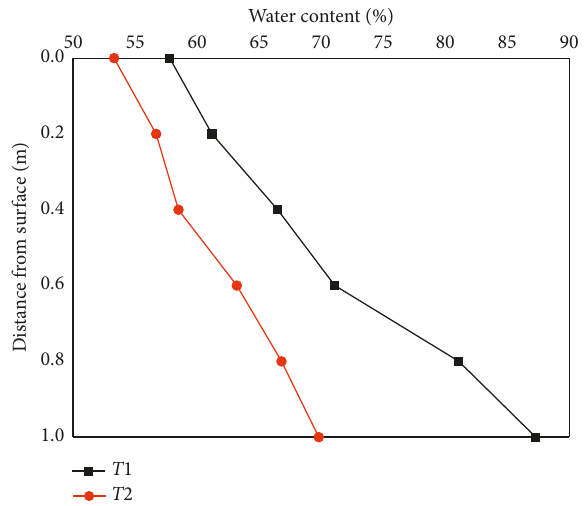
Figure 7: Variations in the water content with the soil depth plotted for cylinders T 1 and T 2.